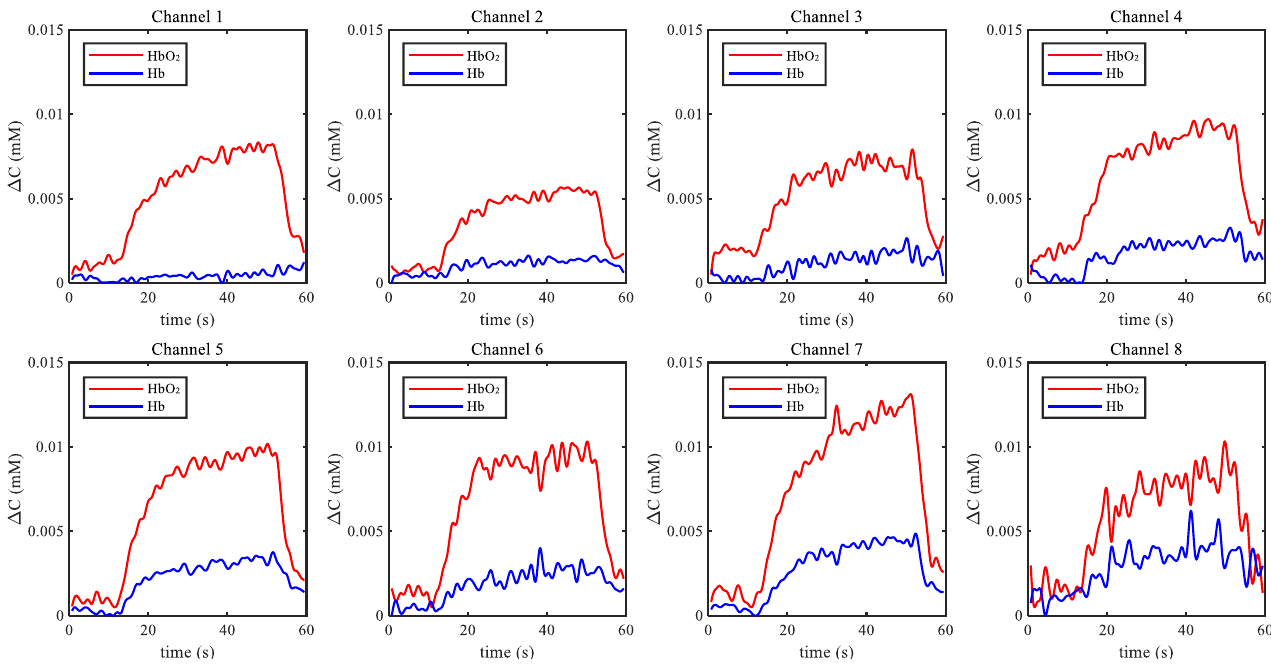
Figure 8. Example of results in the motor imagery experiment.